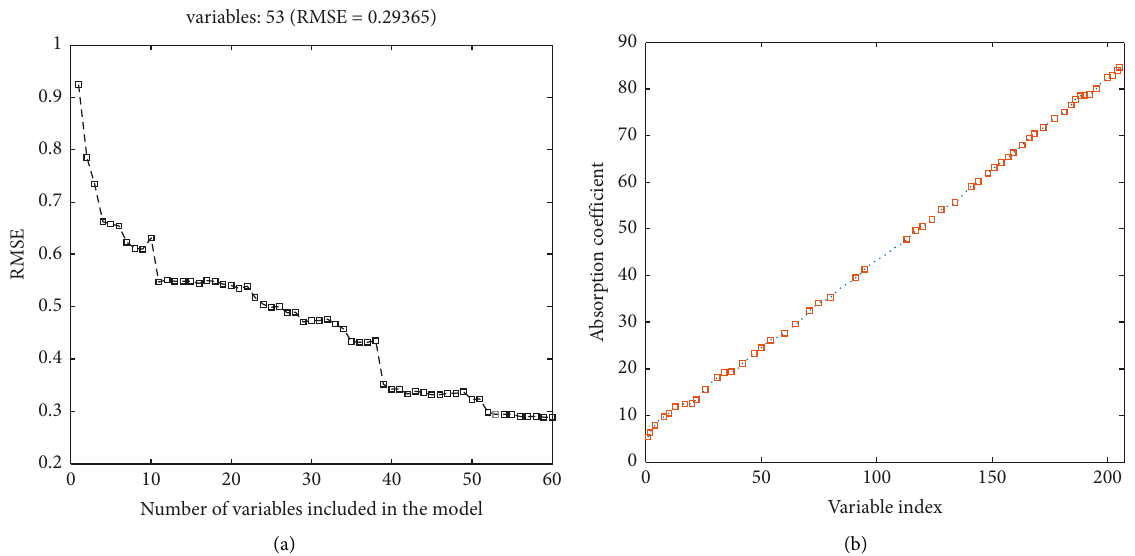
Figure 4: The characteristic variable selection results of SPA, (a) the RMSE distribution with the number of variables; (b) the variable distribution by